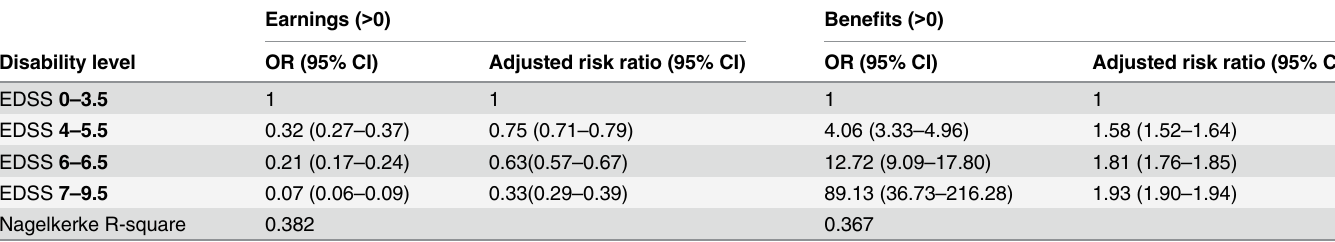
Table 1. Odds ratios with approximated risk ratios for having income among MS patients with different disability